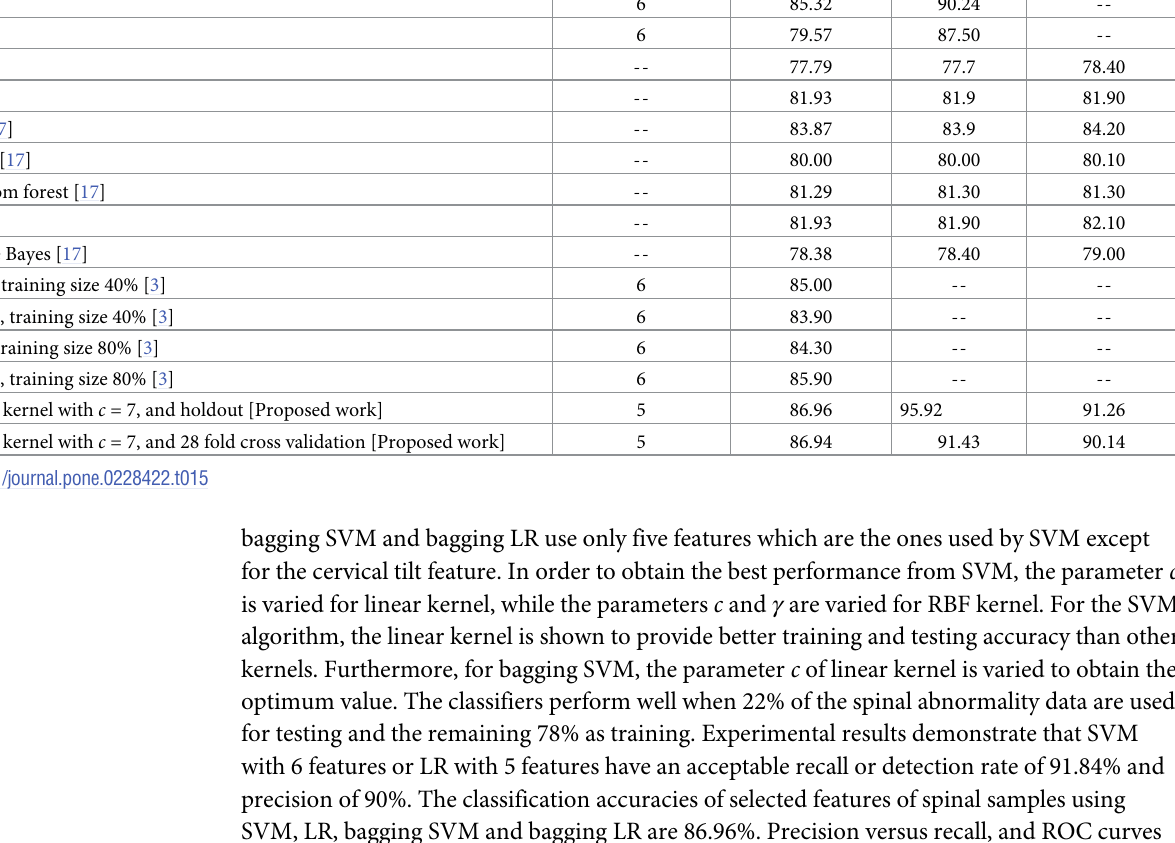
Table 15. Comparison of the proposed work with previous